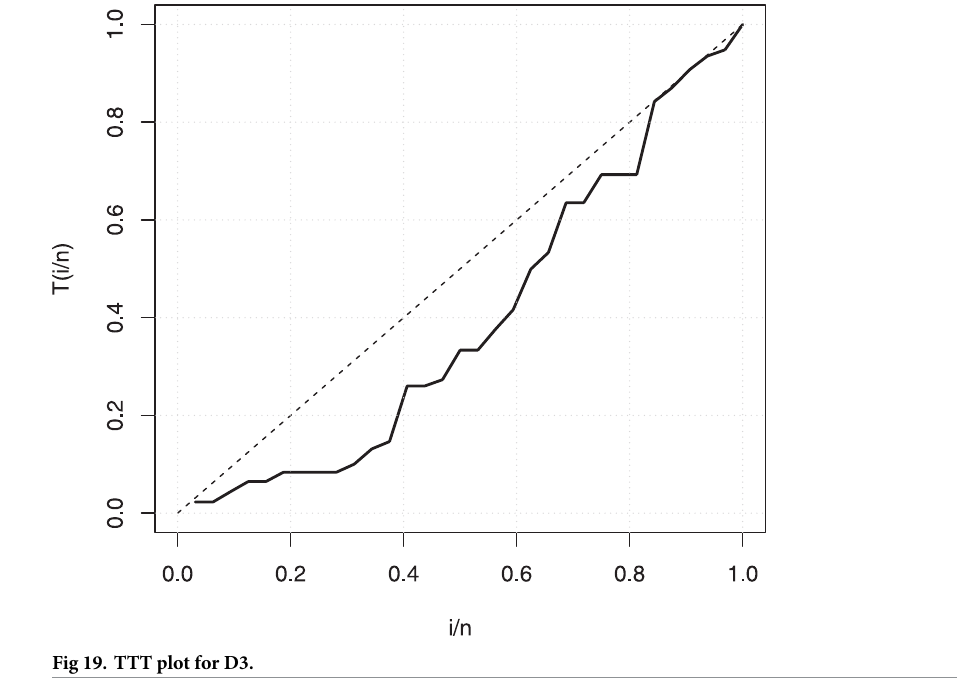
Fig 19. TTT plot for D3.